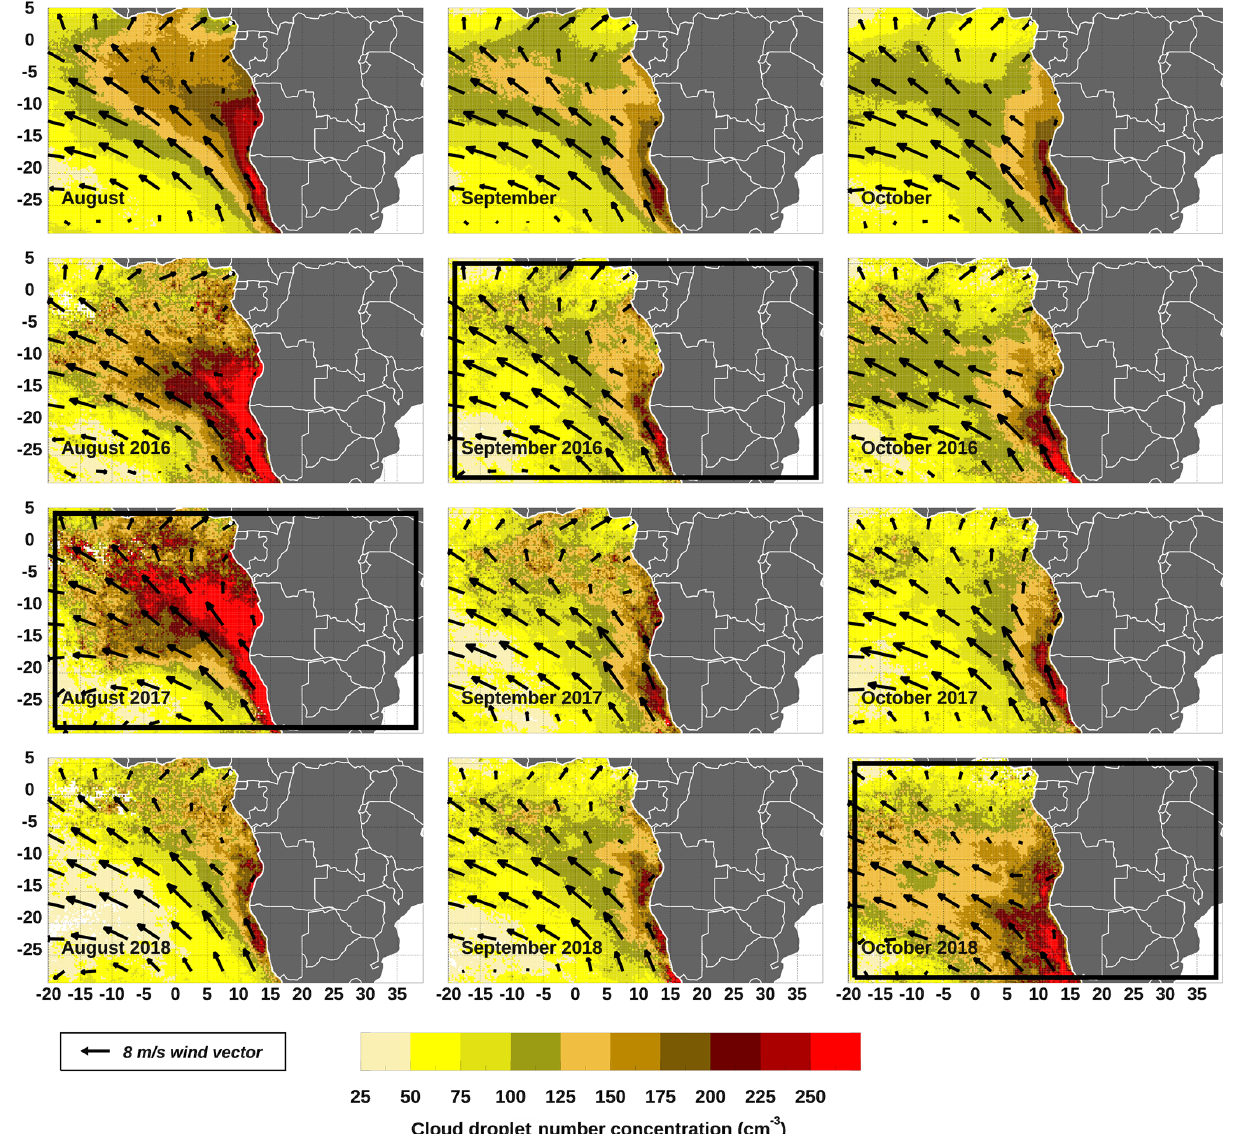
Figure 10. As in Fig. 9, but for N c from combined Terra–Aqua retrievals for August, September, and October, aggregated at 0.1 ◦ . Black arrows denote 925mb wind vectors with 8ms − 1 wind vector scale shown in the black box. The bold black frames indicate ORACLES deployment